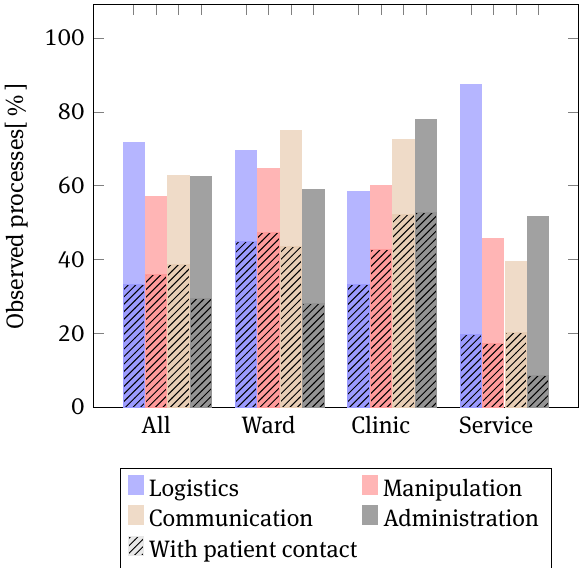
Figure 3: The distribution of the processes wrt. to type of the ac- tions involved (indicated by the color) and whether a patient is involved or not. Since a process might be composed of multiple actions of different type, the different types sum up to >100%.